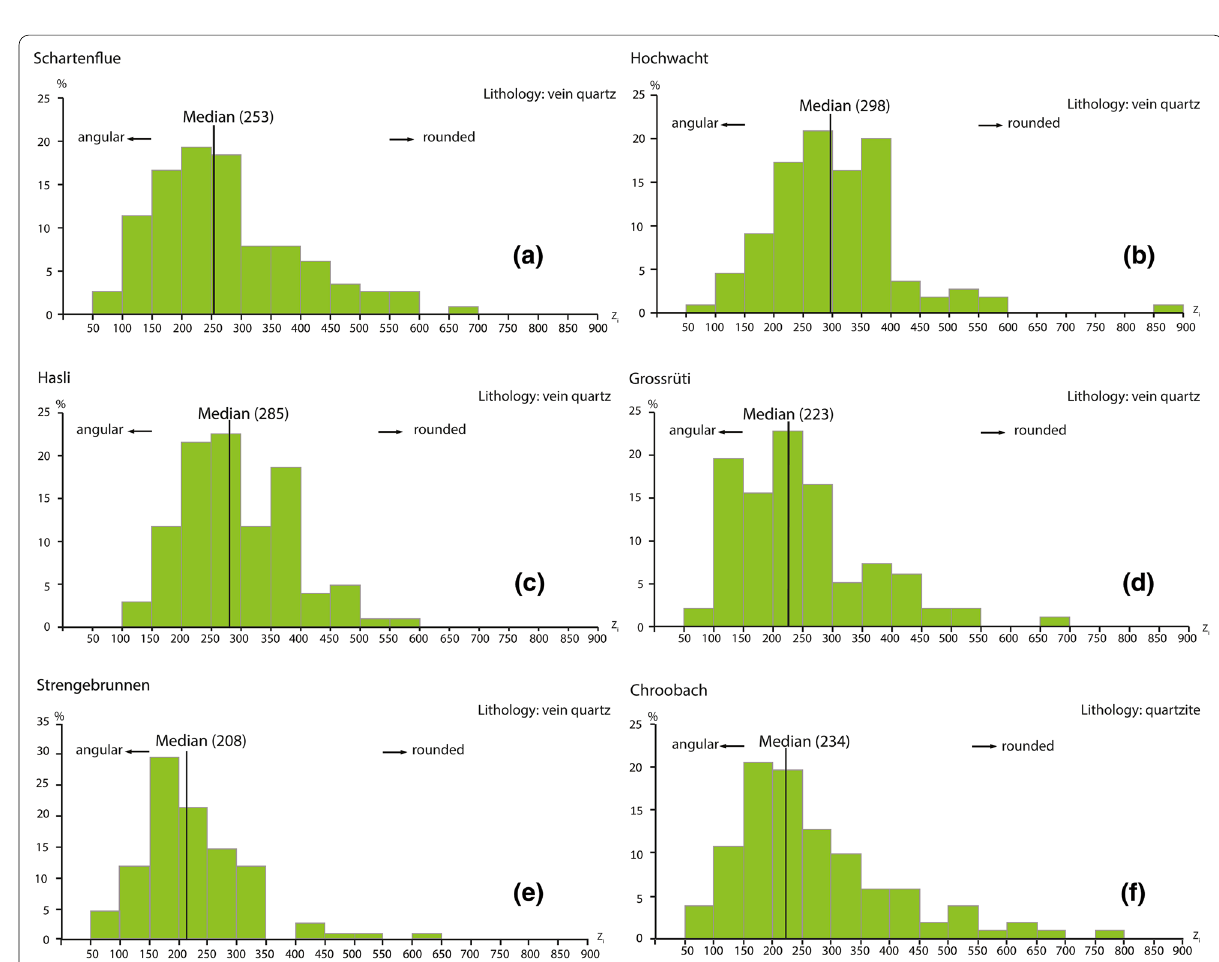
Fig. 10 Roundness index histograms at the study sites: a Schartenflue; b Hochwacht; c Hasli; d Grossrüti; e Strengebrunnen; and f